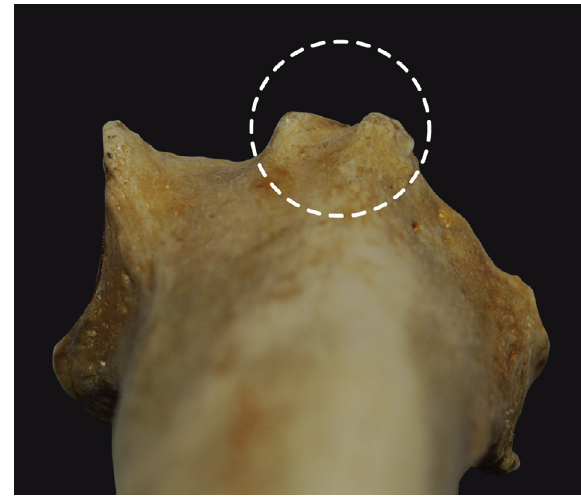
Figure 5. A superior view of the wrist showing the distal dorsal (Lister’s) tubercle and the EPL groove (dotted line).